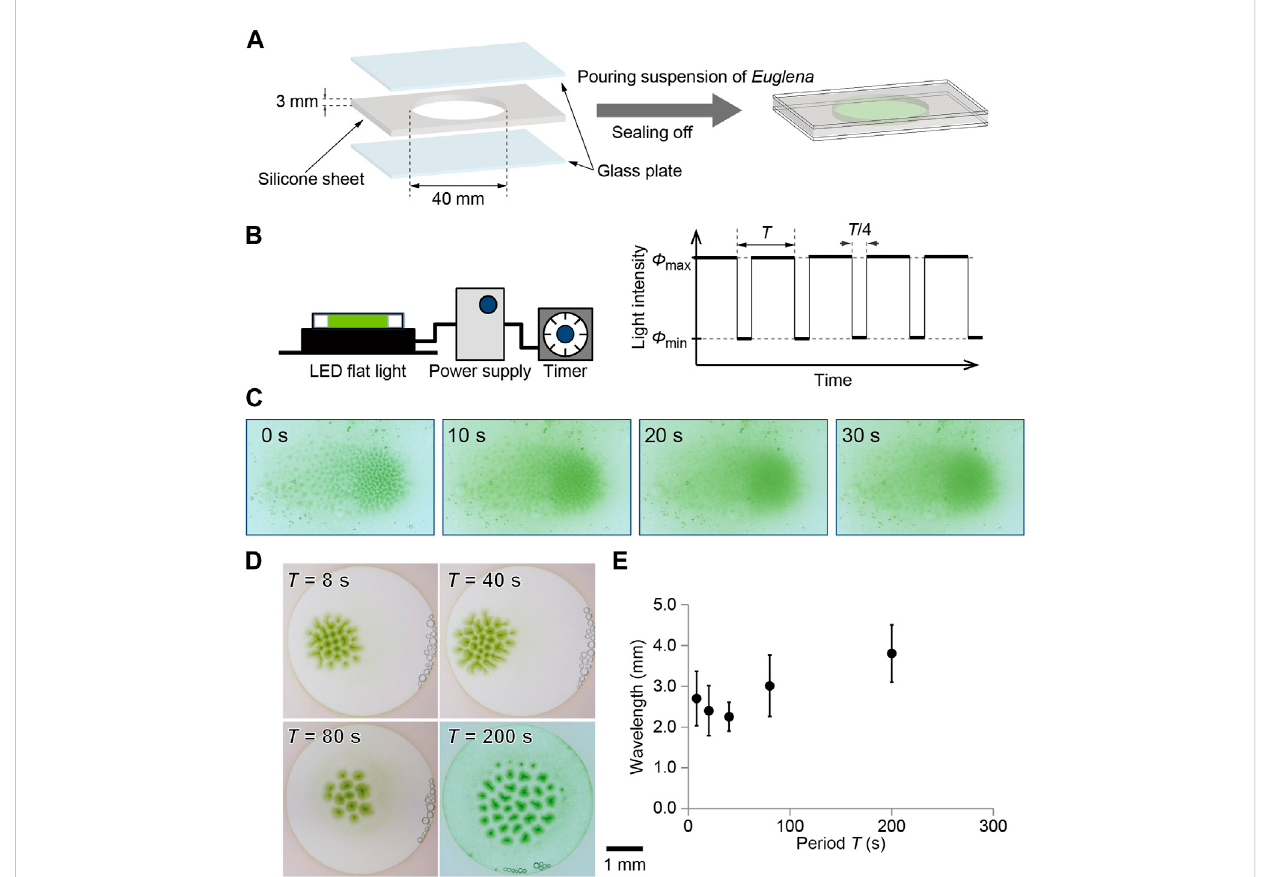
FIGURE 1 Illustrationfor (A) samplepreparationand (B) temporalchangeinlightillumination.Acultureof Euglena wasencapsulatedusingglassplates,wherea siliconesheetwasusedasaspacer.Thesamplewasilluminatedfromthebottomusing fl atlightwhoseintensitywascontrolledwiththe Arduino .Thelight intensity was periodically changed between 0 and 3000 lx, where three quarters was bright and one quarter was dark. (C) Decomposition process of bioconvectionpatternafterstoppingtheilluminationfromthebottom. (D) Bioconvectionpatterngeneratedwithtemporalchangeinlightintensity. Thetimeperiodswere8,20,40,80,and 200 s.Thesnapshotsobtained at60 minareshown hereforeachperiod. (E) Characteristic wavelengthfor each pattern depending on the period. The snapshots obtained at 60 min were analyzed for each